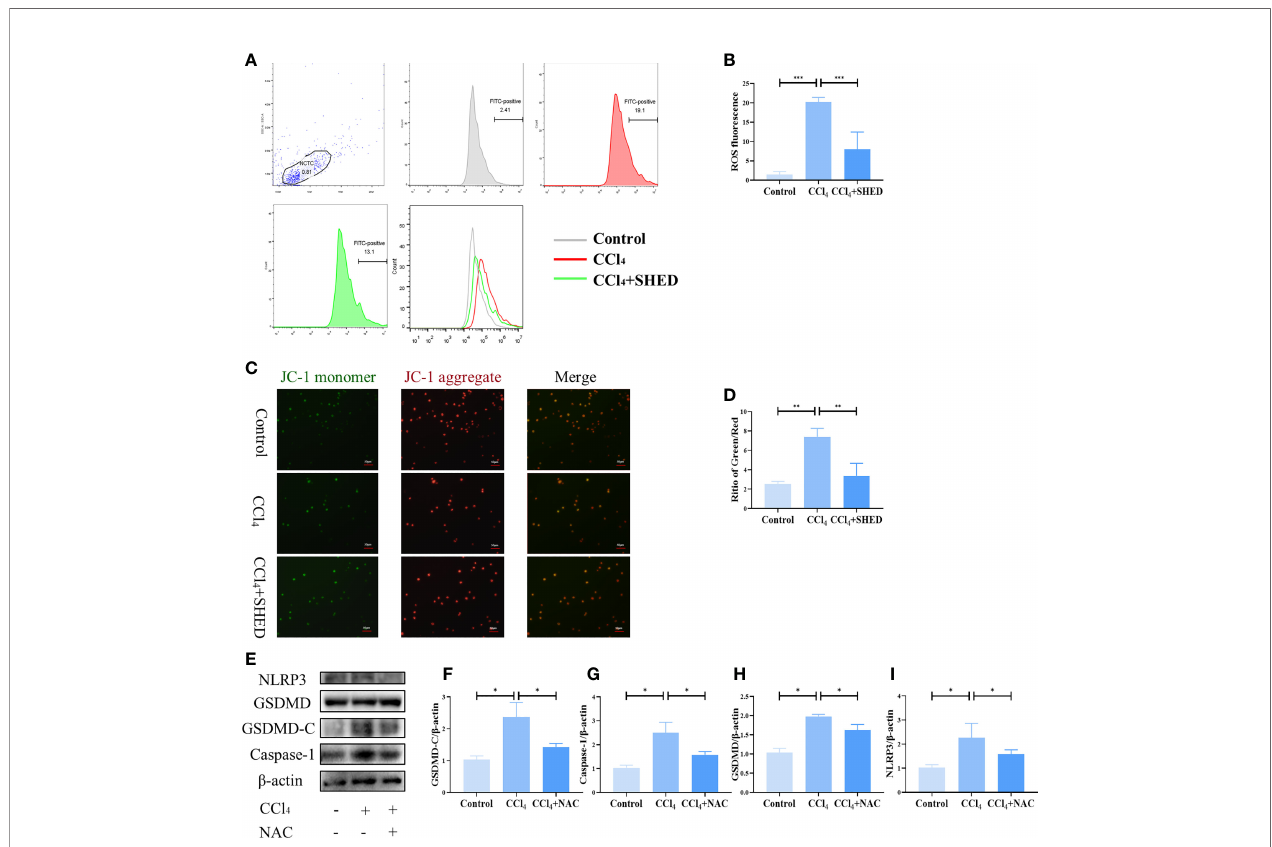
FIGURE 4 | SHED attenuated CCl 4 -induced pyroptosis of hepatocytes by reducing ROS. (A, B) The intracellular ROS of hepatocytes in control, CCl 4 , and CCl 4 +SHED groups was analyzed by fl ow cytometric analysis. (C, D) MMP was measured by JC-1 staining of hepatocytes in control, CCl 4 , and CCl 4 +SHED